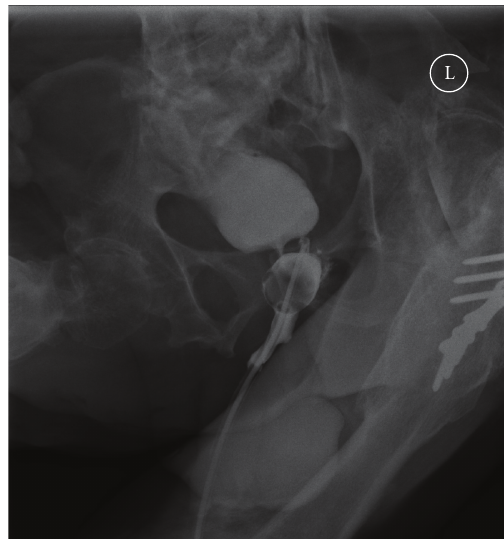
Figure 2: Two mL of contrast was then injected through balloon channel of Foley catheter to visualise the balloon. The balloon could be seen lying in the